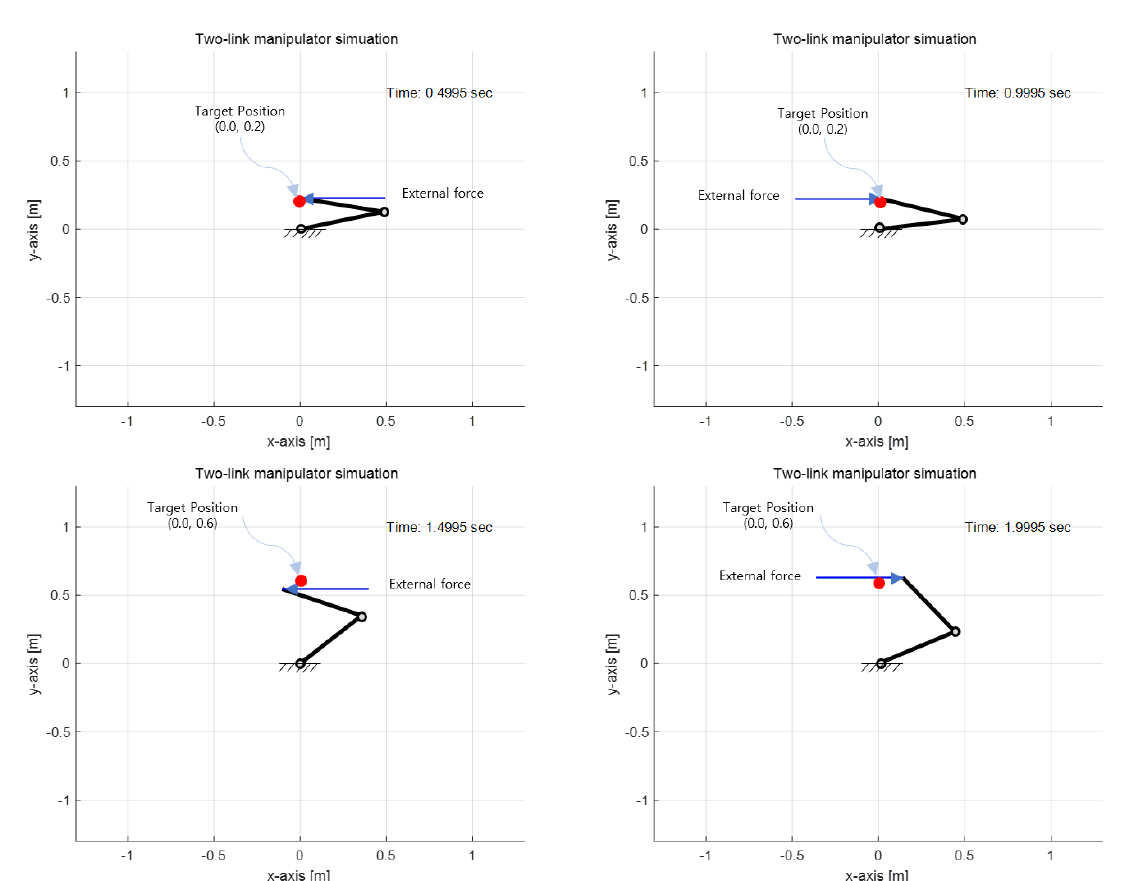
Figure 2. Snapshots of simulation result according to time progress, where the robotic manipulator used in the simulation has two links. The external force is applied to the x-axis direction forward and backward, alternatively, with 0.25 s duration. Also, ( x d , y d ) = ( 0.0,0.2 ) was set at a target position from the beginning, and then the target position was changed into ( x d , y d ) = ( 0.0,0.6 ) at the instant of 1